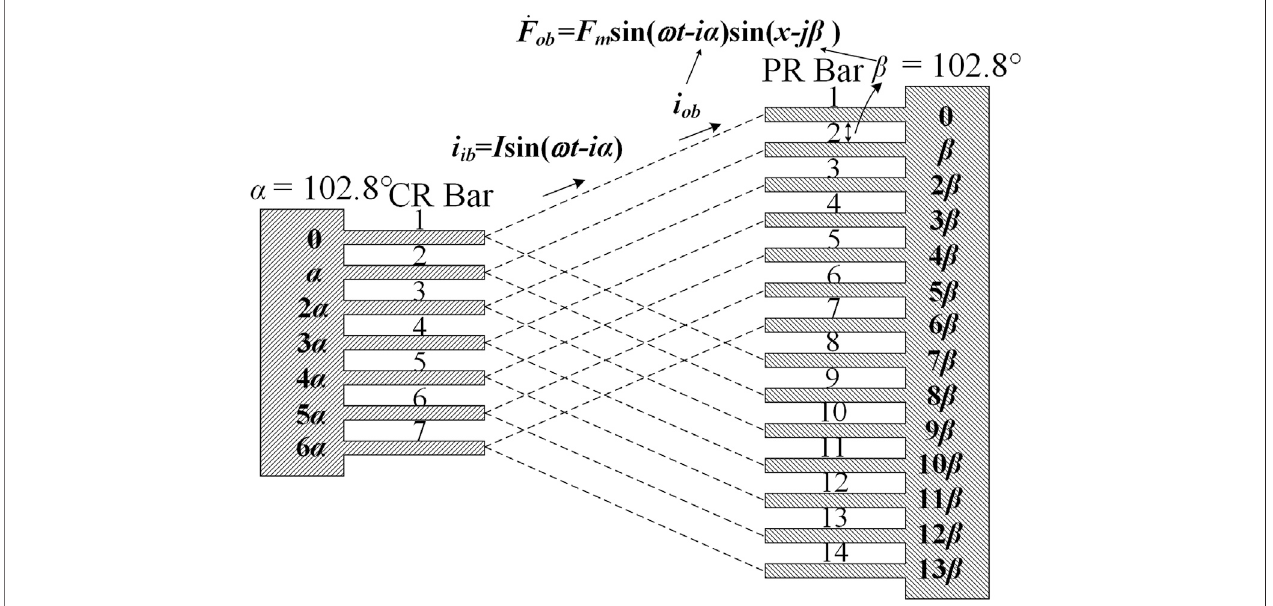
FIGURE 3 | Interconnection between PR bars (4 pole pairs and 14 slots) and CR bars (2 pole pairs and 7 slots).